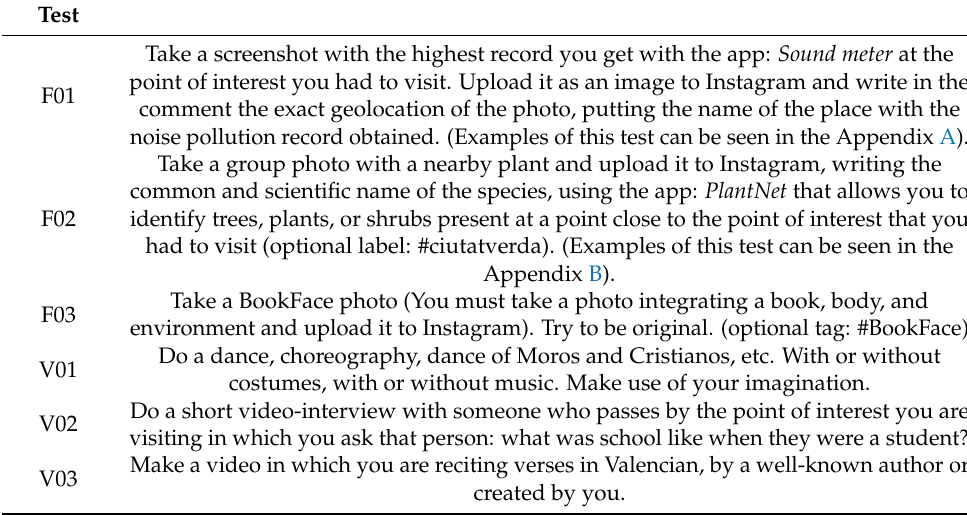
Table 1. Tests to be carried out by the students in the 6 points of